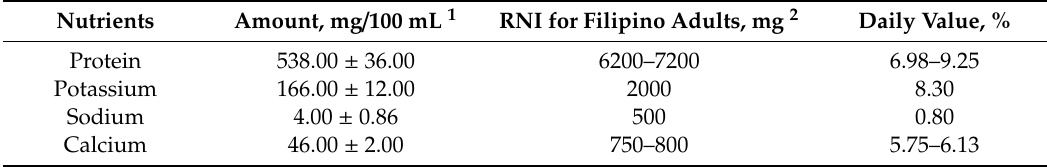
Table 3. Nutritional composition of Ready-to-drink ‘Saba’